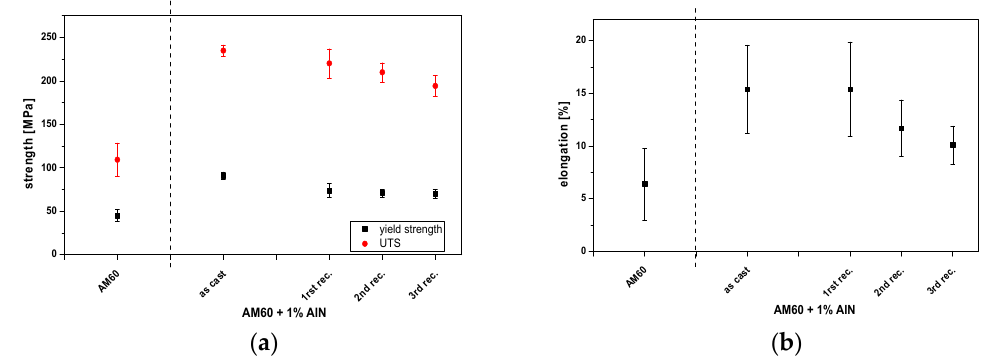
Figure 4. Mechanical properties: ( a ) yield and ultimate tensile strength and ( b ) elongation to fracture.